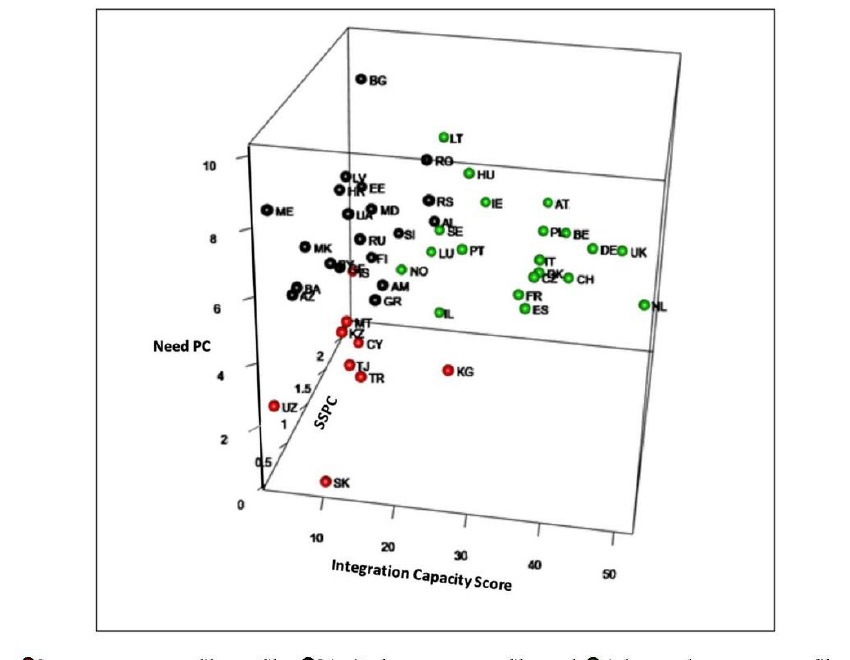
Figure 2. Cluster representation by country integration level.